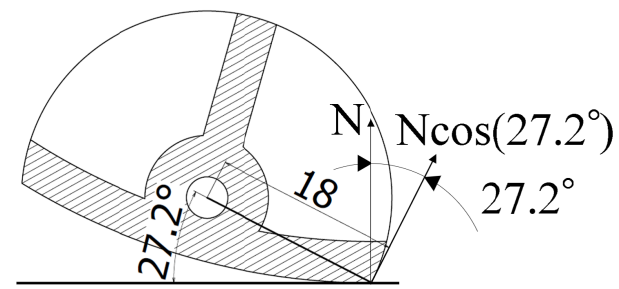
Figure 6. Structural design segment angle γ ( γ =